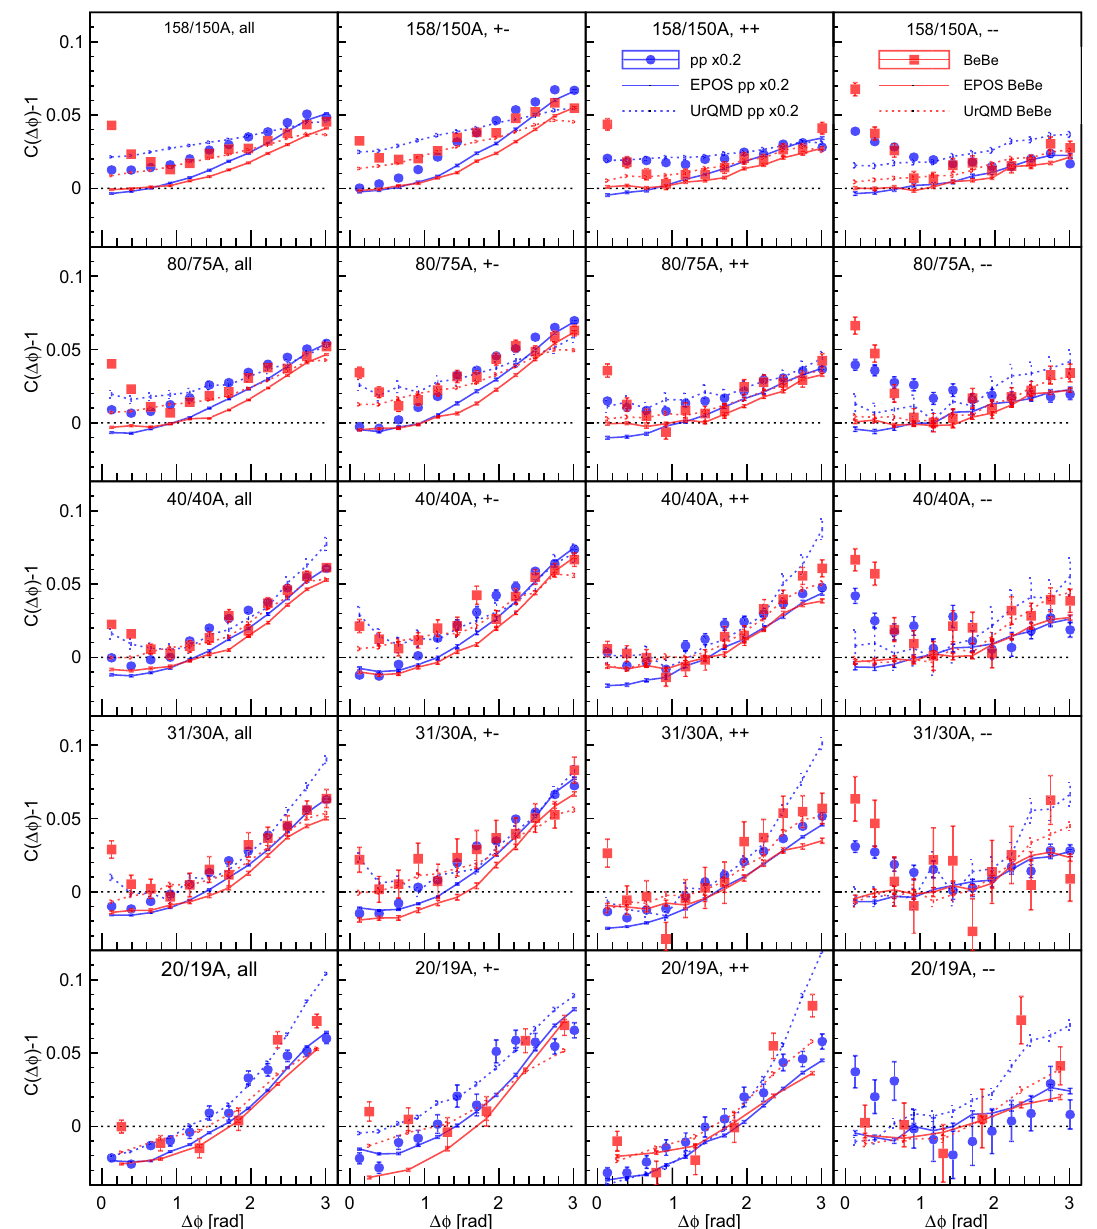
Fig. 12 Comparison of two-particle correlation function C − 1 for the range (cid:2)η ∈ [ 0 , 0 . 5 ) in collisions of p + p (blue) and Be + Be (red). Columns from left to right show results for: all charge pairs, unlike- sign pairs, positive pairs, and negative pairs. Results for different beam momenta are plotted in successive rows. Data results are shown by